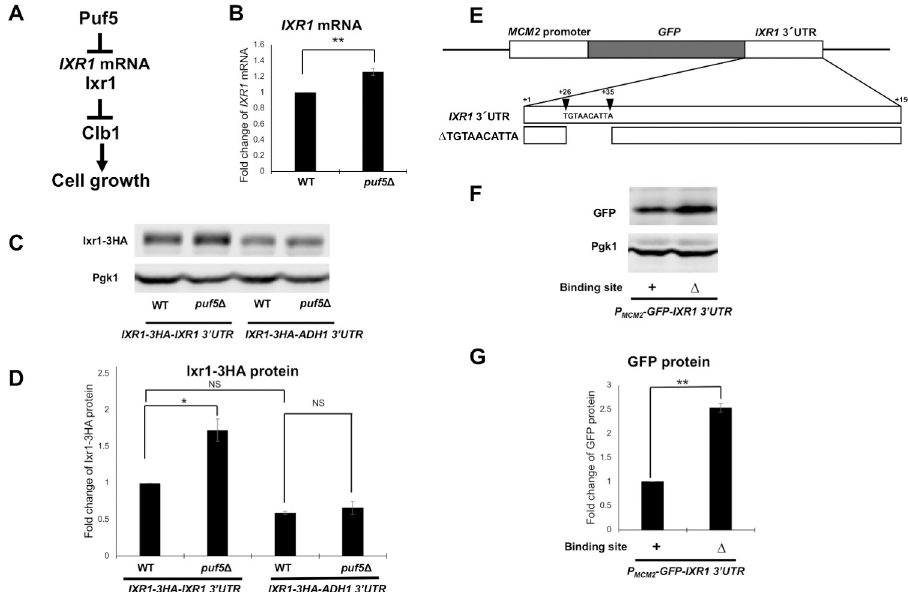
Fig 7. Puf5 negatively regulates IXR1 expression through the IXR1 3’ UTR. (A) A model showing how Puf5 functions in cell growth through the CLB1 regulation, which is mediated by Ixr1. The hypothesis is presented that Puf5 negatively regulates the IXR1 expression through the IXR1 mRNA, and that Ixr1negatively regulates the CLB1 transcription. (B) The IXR1 mRNA levels in wild-type and the puf5 Δ mutant. The cells were cultured in a YPD medium containing 10% sorbitol at 25˚C until the exponential phase. The IXR1 mRNA levels were quantified by qRT-PCR analysis, and the relative mRNA levels were calculated using the SCR1 reference gene. The data shows the mean ± SE (n = 3) of the fold change of IXR1 mRNA relative to the mRNA level in wild-type. � P < 0.05, �� P < 0.01 as determined by Tukey’s test. (C, D) The Ixr1 protein levels in wild-type and the puf5 Δ mutant and the quantitative analysis data of Ixr1-HA protein level. The strains harboring the YCplac33- IXR1- HA -IXR1 3´ UTR plasmid or the YCplac33- IXR1- HA -ADH1 3´ UTR plasmid were cultured in an SC-Ura medium at 28˚C. The extracts were immunoblotted with anti-HA antibody or anti-Pgk1 antibody. Ixr1-HA protein level was quantified and normalized with the Pgk1 protein level. The data shows the mean ± SE (n = 3) of the fold change of Ixr1-HA protein relative to the protein level in wild-type harboring the YCplac33- IXR1- HA -IXR1 3´ UTR plasmid (D). � P < 0.05, �� P < 0.01 as determined by Tukey’s test. (E) Scheme of the YCplac33- IXR1- HA -IXR1 3´ UTR plasmid. Δ TGTAACATTA harbors the deletion of the sequence encoding the Puf5-binding site of IXR1 mRNA, 5´-TGTAACATTA. Described numbers correspond to the number of bases from the stop codon of IXR1 . (F, G) The GFP protein levels and the quantitative analysis data of GFP protein level in wild-type strain compared by the presence of the Puf5-binding site deletion. The strains harboring the YCplac33- MCM2 promoter -GFP-IXR1 3´ UTR plasmid with or without the Puf5-binding site were cultured in an SC-Ura medium at 28˚C. The extracts were immunoblotted with anti-GFP antibody or anti-Pgk1 antibody. GFP protein level was quantified and normalized with the Pgk1 protein level. The data shows the mean ± SE (n = 3) of the fold change of GFP protein relative to the protein level in the strains harboring the YCplac33- MCM2 promoter -GFP-IXR1 3´ UTR plasmid with the Puf5-binding site (G). � P < 0.05, �� P < 0.01 as determined by Tukey’s